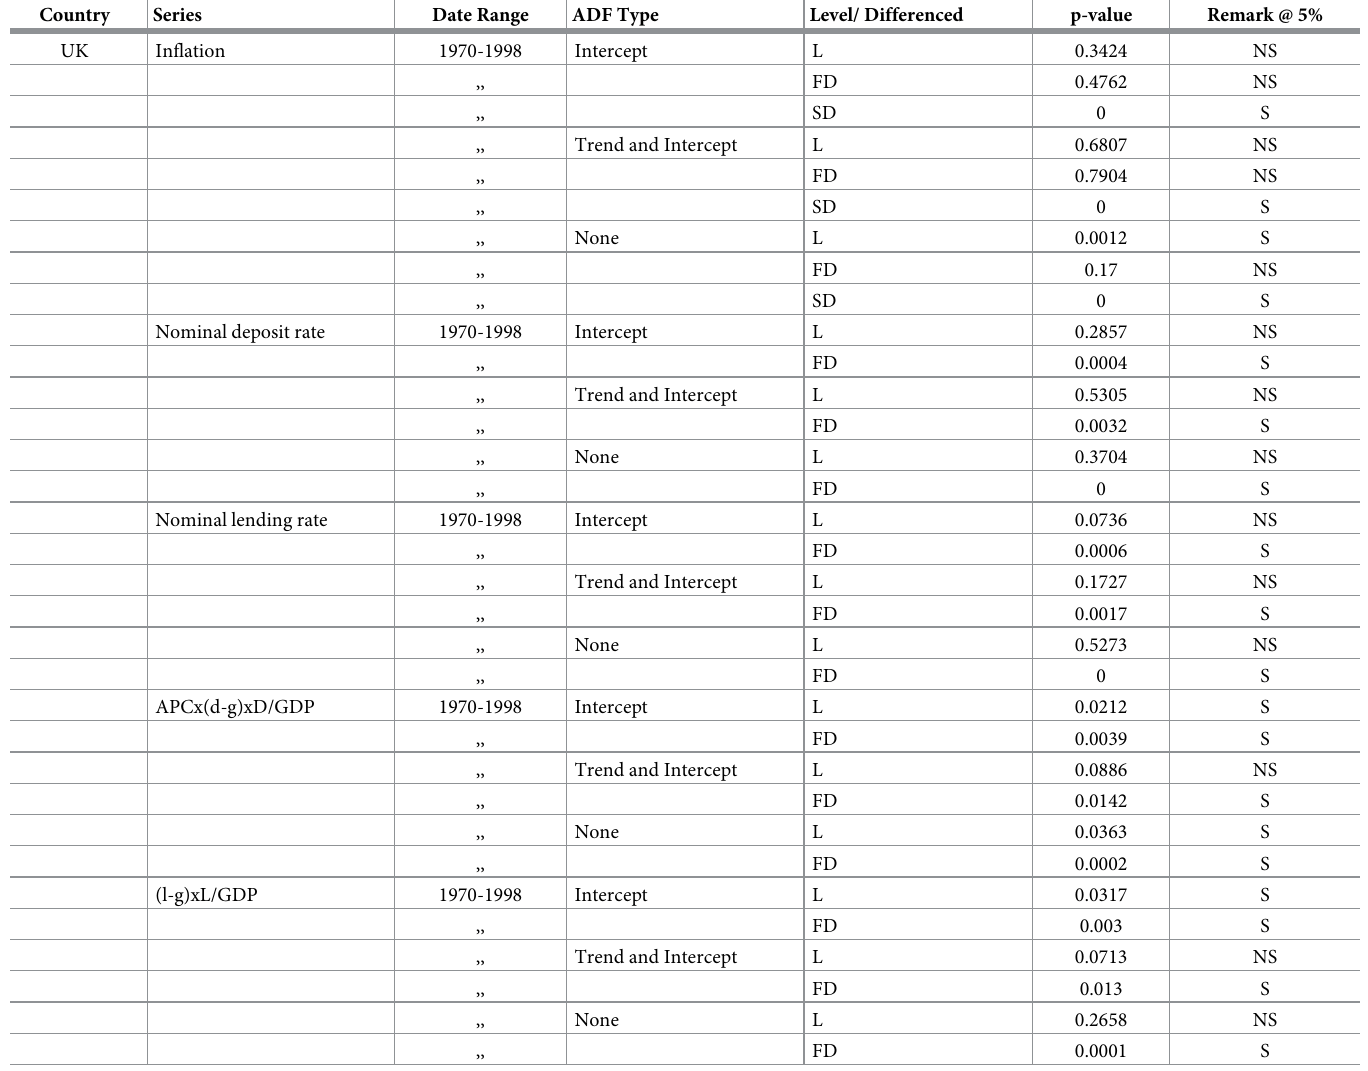
Table 5. ADF Unit Root Test.